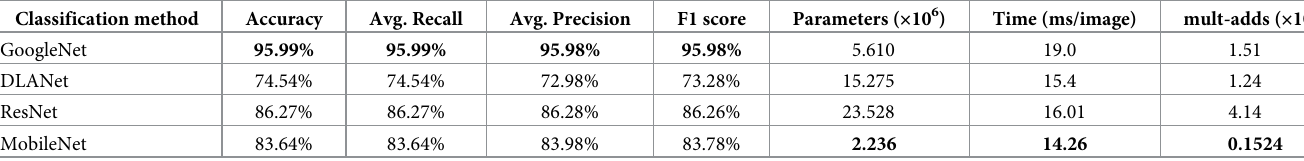
Table 2. Classification performances obtained with four CNN models for the real-world testing dataset. Classification